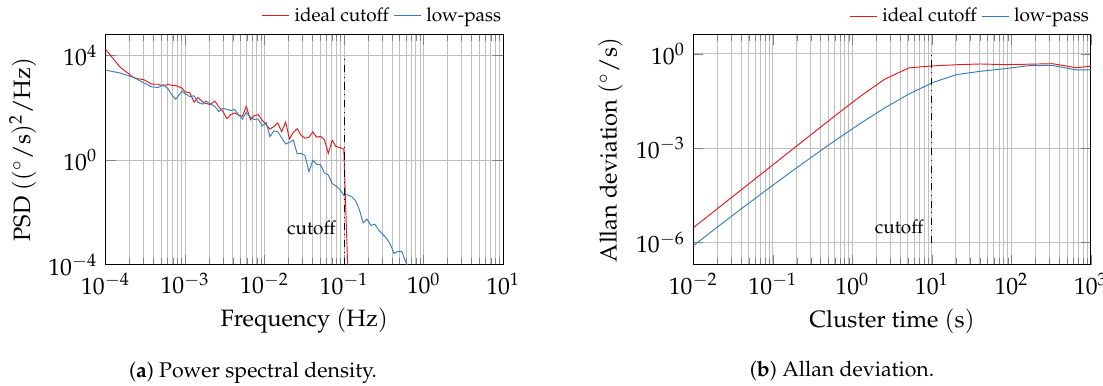
Figure 7. Comparison of the power spectral density (PSD) and Allan variance of simulated bias instability signals for a sharp cutoff and first-order low-pass